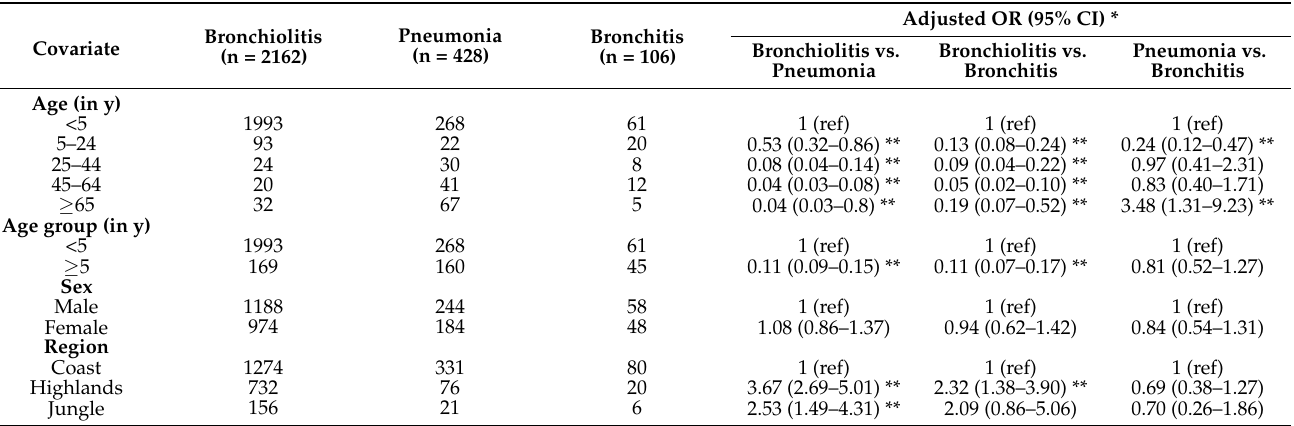
Table 4. RSV respiratory tract infections by age, sex, and region in hospitalized patients in Peru, 2015–2021.